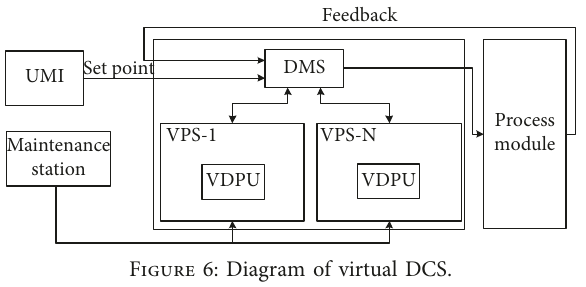
Figure 6: Diagram of virtual DCS.